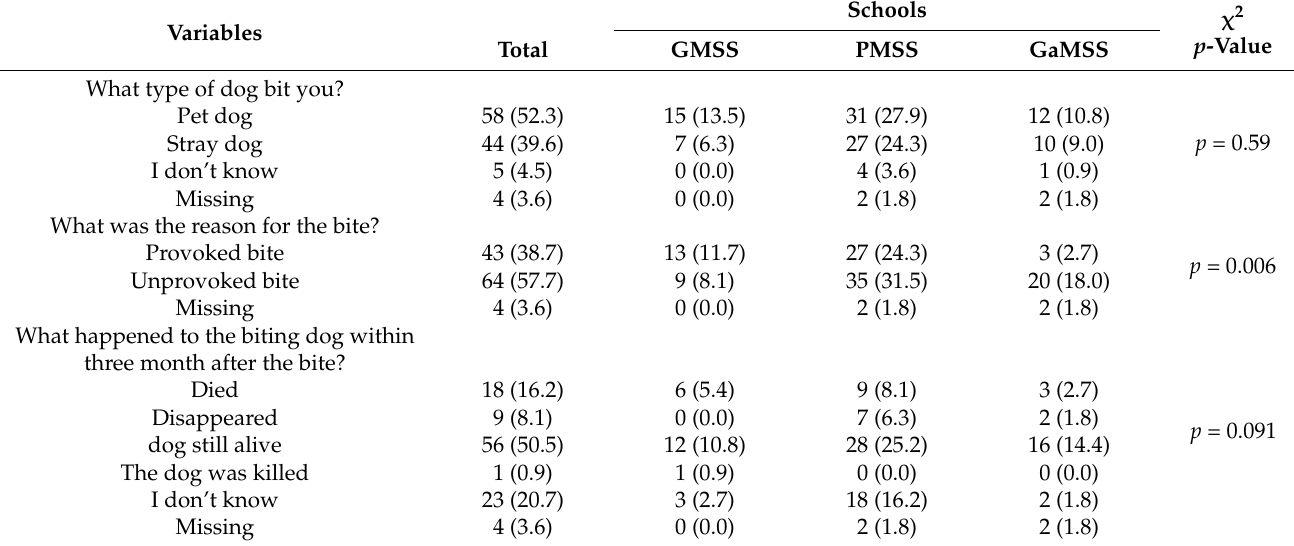
Table 3. Characteristics of dog bites and health-seeking behaviors among students bitten by dogs ( n = 111).